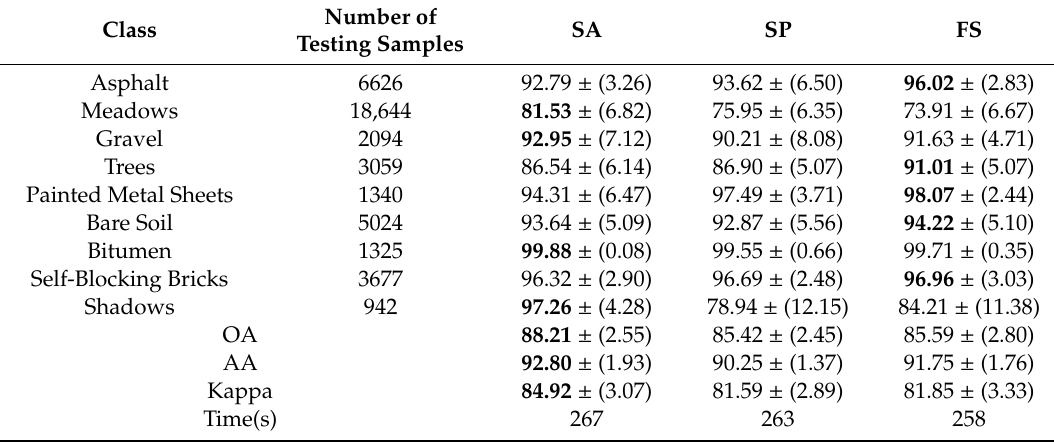
Table 2. CAs, OAs, AAs, kappa (as a percentage, with the standard deviation in brackets), and running time average statistics obtained with unlabeled samples selected from SA-, SP-, and FS- based neighborhood for Pavia University